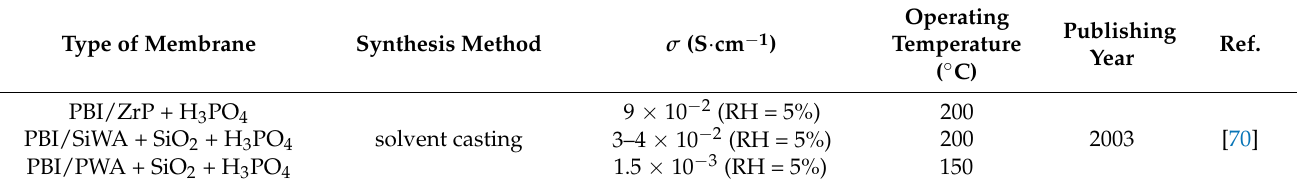
Table 1. The membrane properties of some representative studies on promoting the proton conductivity of PBI PEMs in hydrogen-air PEMFCs by acid